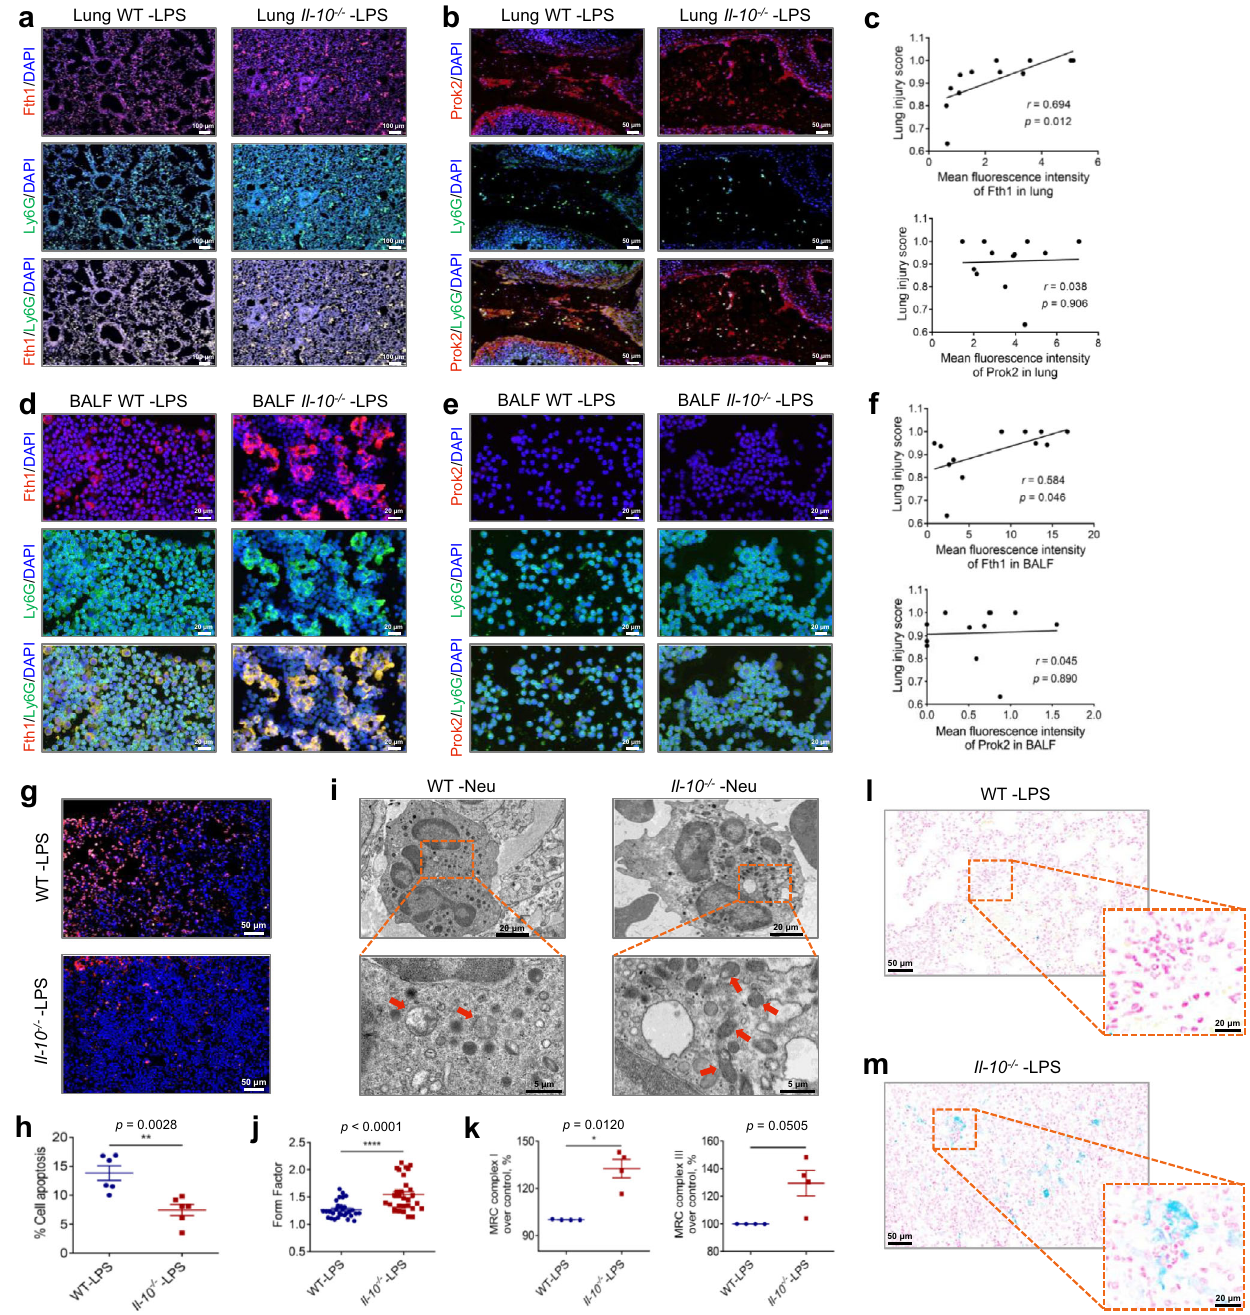
Fig. 6 | Il-10 − / − -prolonged survival of pulmonary Fth1 hi Neu exacerbates lung injury. a , b Representative images of anti-Fth1/anti-Ly6G ( a ) and anti-Prok2/anti- Ly6G ( b ) immuno fl uorescence-stained lung tissues of WT and Il-10 − / − mice at 24h afterLPSchallenge.ThenucleiwerestainedwithDAPI,displayedinblue.Scalebars in( a ),100 µ m;scalebarsin( b ),50 µ m. c TherelationshipbetweenpulmonaryFth1, Prok2 expression and lung injury score, n =12. d, e Representative images of anti- Fth1/anti-Ly6G ( d ) and anti-Prok2/anti-Ly6G ( e ) immuno fl uorescence-stained air- way in fl ammatory cells of WT and Il-10 − / − mice at 24h after LPS stimulation. The nuclei were stained with DAPI, displayed in blue. Scale bars, 20 µ m. f The rela- tionship between BALF Fth1, Prok2 expression and lung injury score, n =12. g Immuno fl uorescence staining for TUNEL (red) and nuclei (blue) in lung sections at 24h post-exposure. Scale bars, 50 µ m. h Quanti fi cation of the apoptosis ratio of airway neutrophils from ALI mice by fl ow cytometry, n =6 in each group.